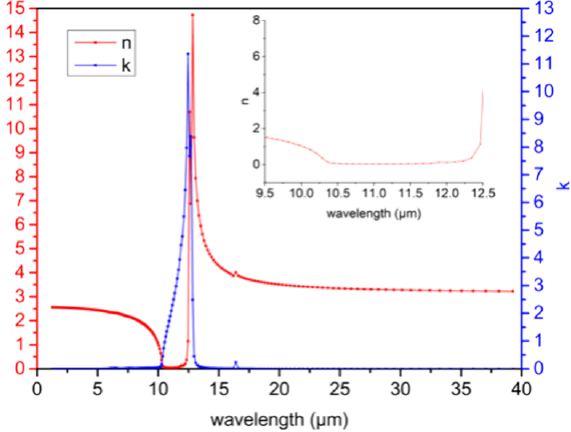
Figure 5. Complex refractive index of SiC particle changes with different